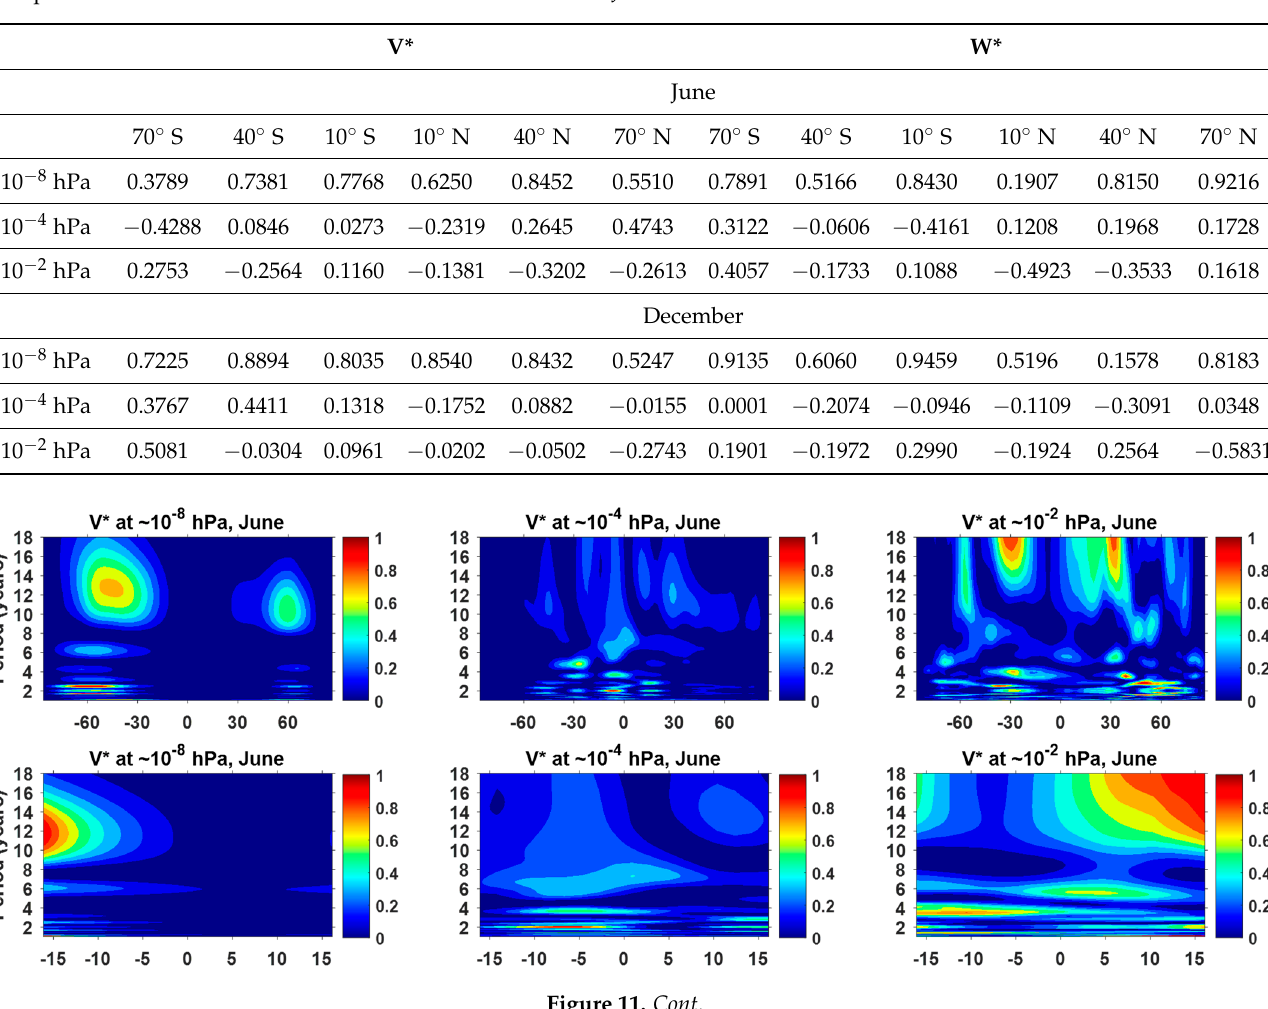
Figure 11. Spectra for the meridional components of atmospheric circulation at ~10 − 8 hPa (left column), ~10 − 4 hPa (middle column) and ~10 − 2 hPa (right column) in June (first two rows) and December (last two rows).